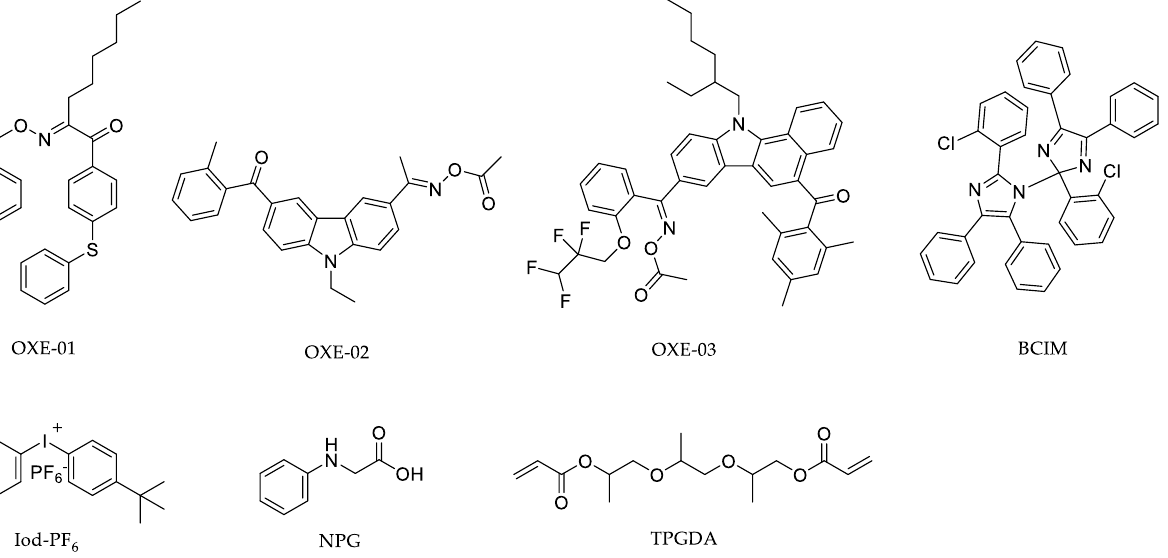
Figure 1. Structures of the commercialized oxime ester PIs (OXE-01, OXE-02, OXE-03), hex- aarylbiimidazole (BCIM), iodonium hexafluorophosphate (Iod-PF 6 ), N - tert -butyl-2-phenylnitrone (NPG) and Tri-(propylene glycol) diacrylate (TPGDA) used in this